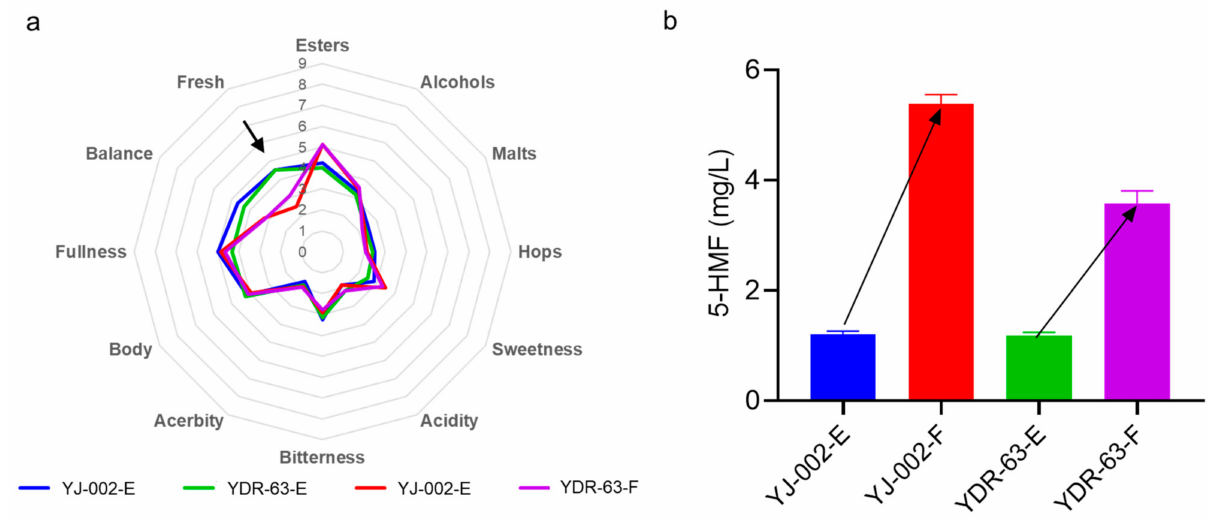
Figure 5. ( a ) Sensory analysis of the beer produced by the strain YDR-63 and strain YJ-002. ( b ) Detecting the levels of 5-HMF in beer samples to reflect the beer aging degree. Samples collected at the end of storage were marked with the tail E while the samples with forced aging treatment were marked with the tail